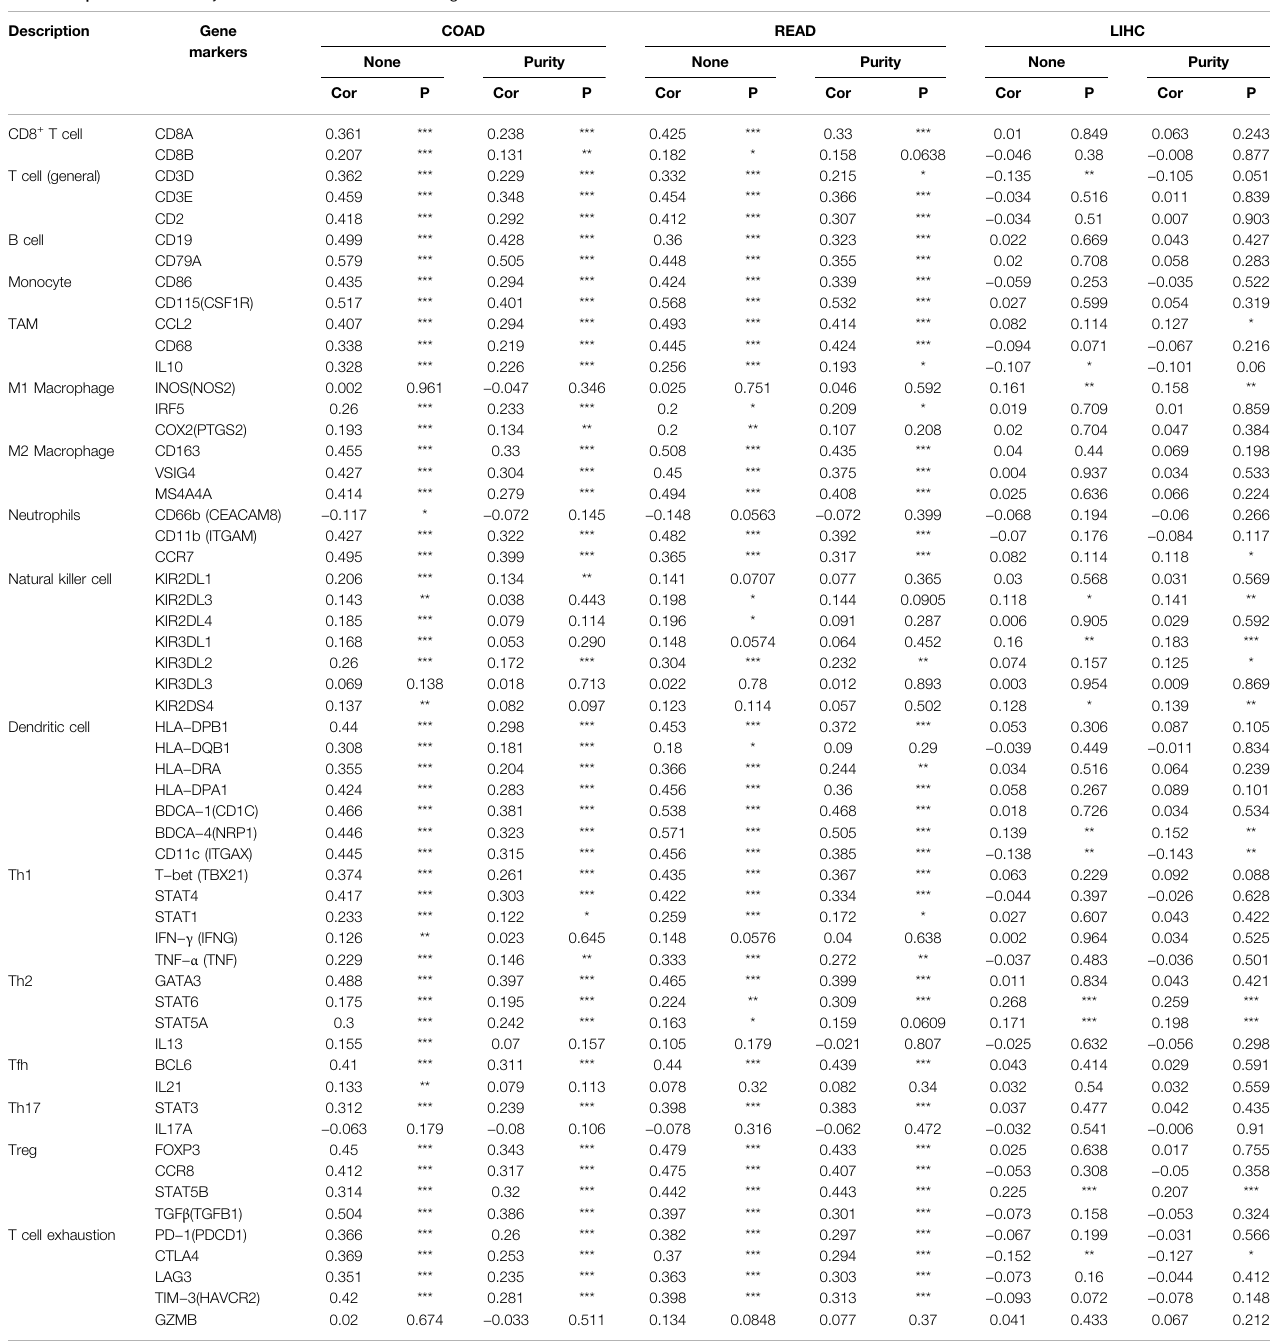
TABLE 2 | Correlation analysis between GNG7 and relate genes and markers of immune in fi ltration cells in TIMER. Description Gene